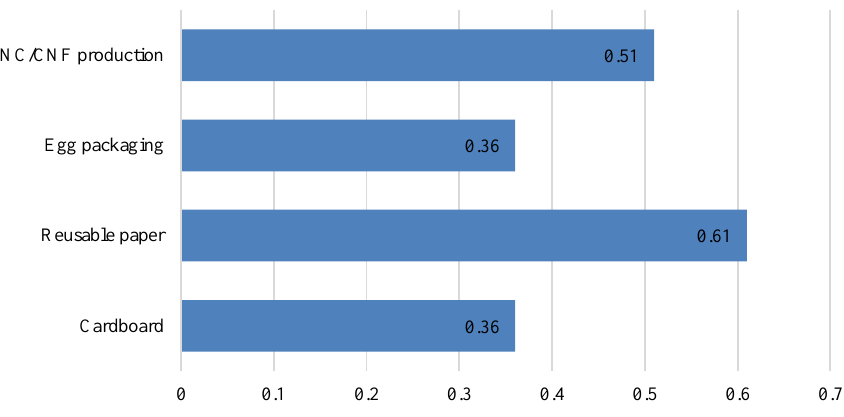
Fig. 4. Results of multi-criteria